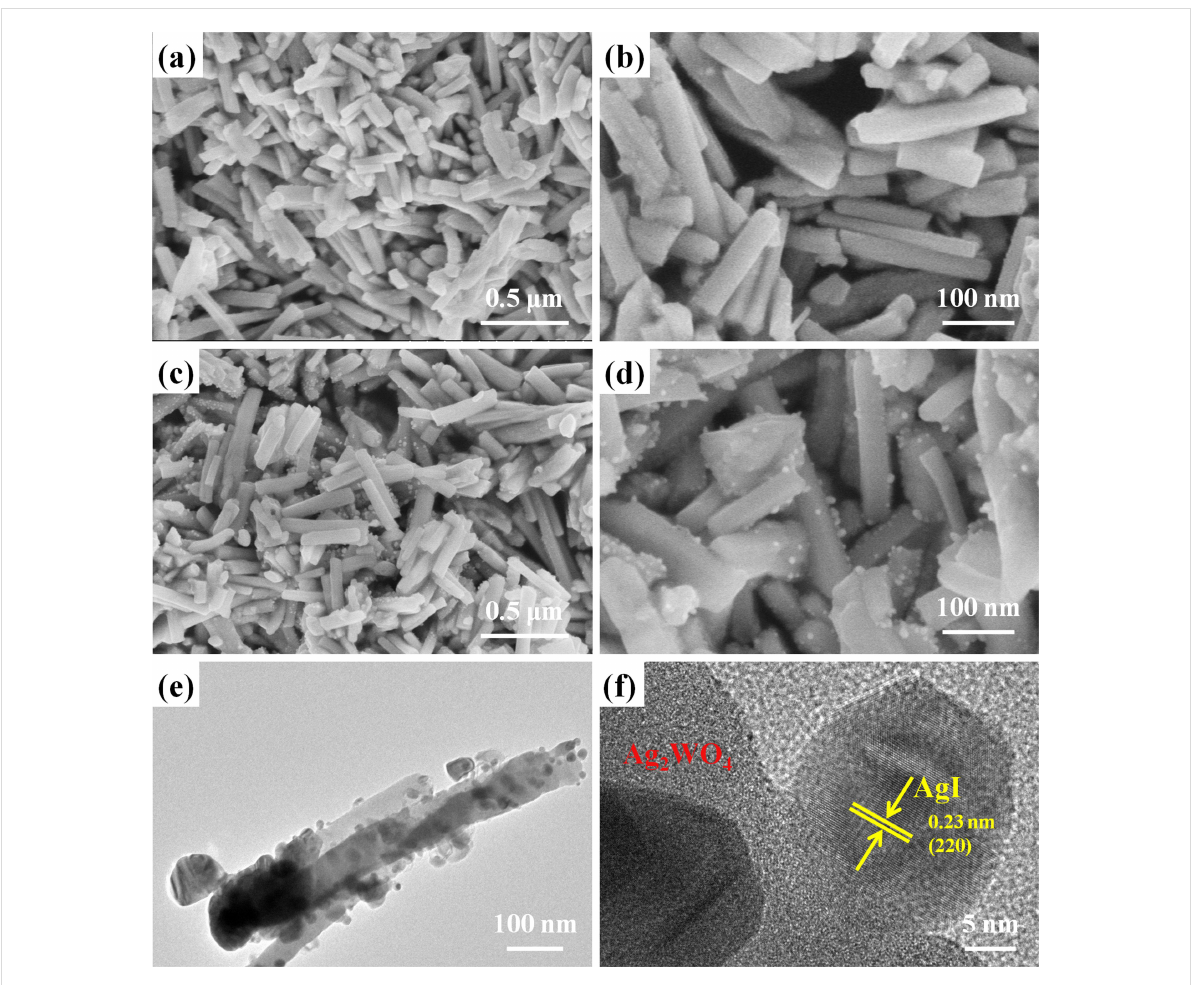
Figure 2: SEM (a, b) images of Ag 2 WO 4 ; SEM (c, d), TEM (e), and HRTEM (f) images of 0.3AgI/Ag 2 WO 4 .